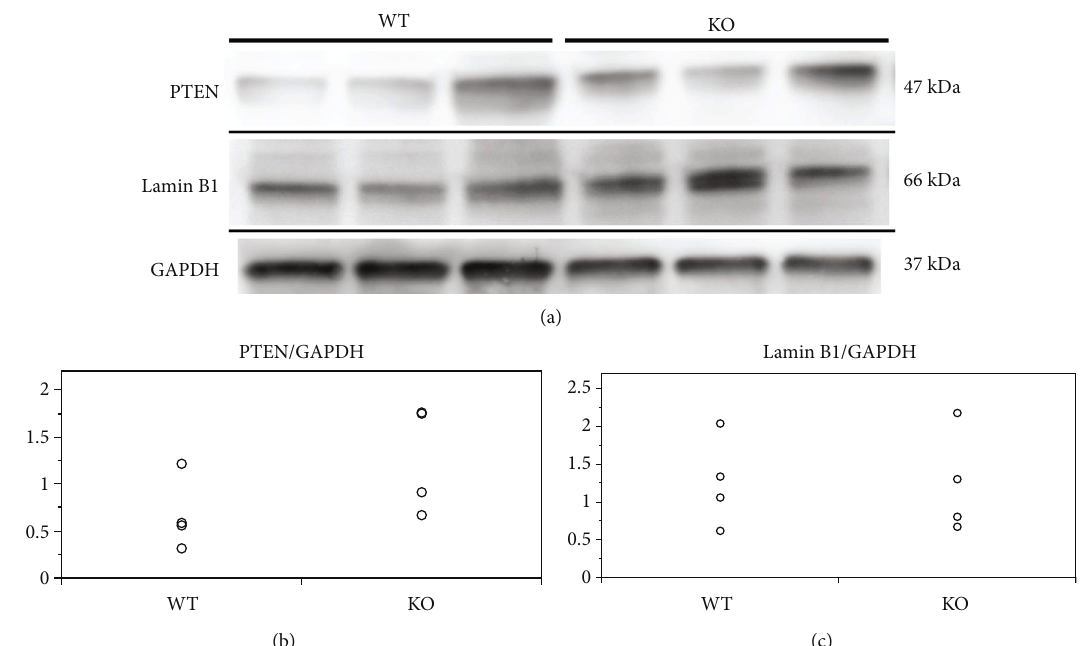
Figure 10: Expression of candidate targets of miR-23-27-24 cluster. Wild-type (WT) and miR-23-27-24 cluster knockout (KO). (a) Representative western blots depicting phosphatase and tensin homolog deleted on chromosome 10 (PTEN) and lamin B1 levels in the spinal cord of 10-week-old mice. (b) PTEN expression was not signi fi cantly di ff erent between WT and KO mice, n = 5 per genotype. (c) Lamin B1 expression was not signi fi cantly di ff erent between WT and KO mice, n = 5 per genotype. (d) Proteome analysis of the spinal cord tissue from 10-week-old mice, n = 1 per genotype. Leucine-zipper-like transcription regulator 1 (LZTR1) was strongly expressed in KO mice compared to WT